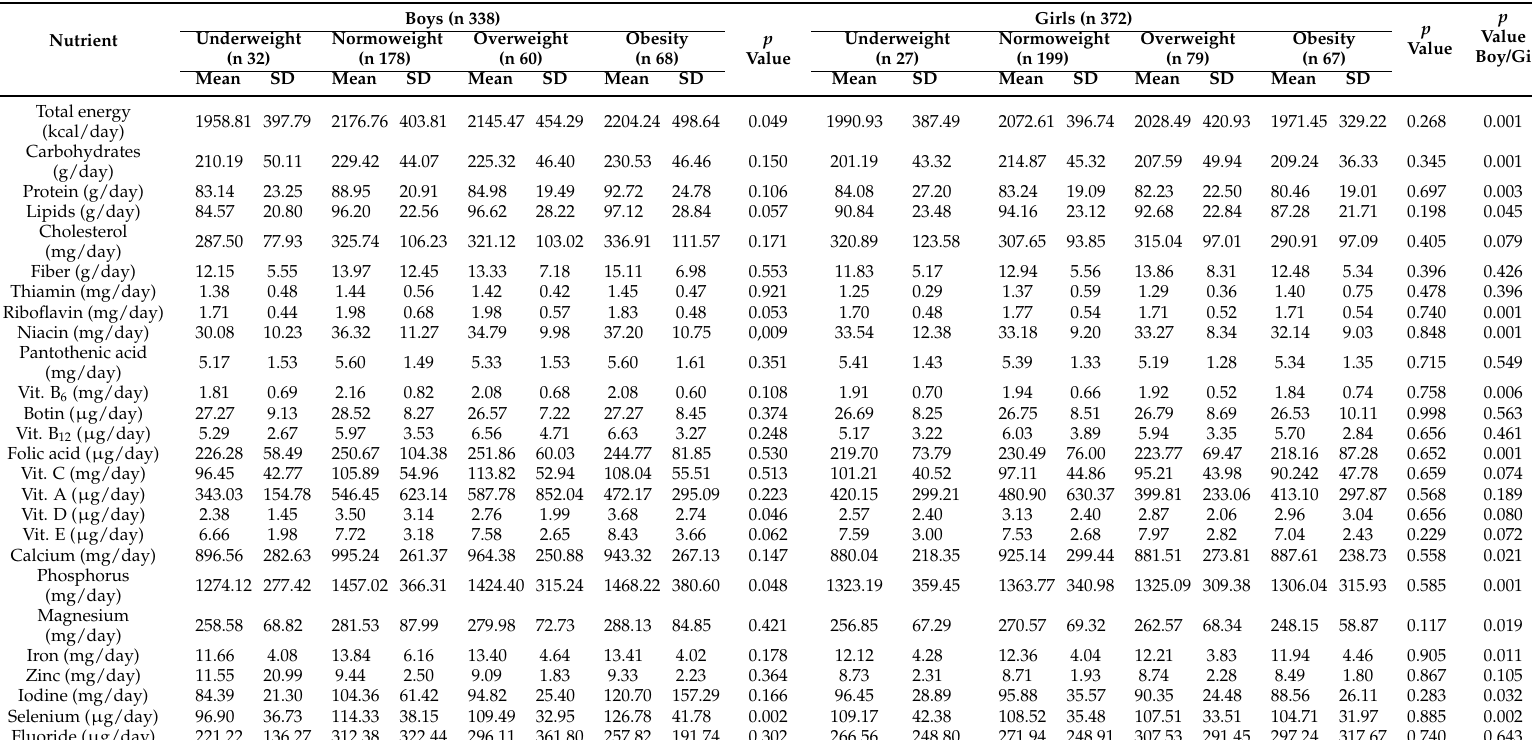
Table 2. Nutritional characteristics of the sample according to BMI in children aged 6–9 years of both